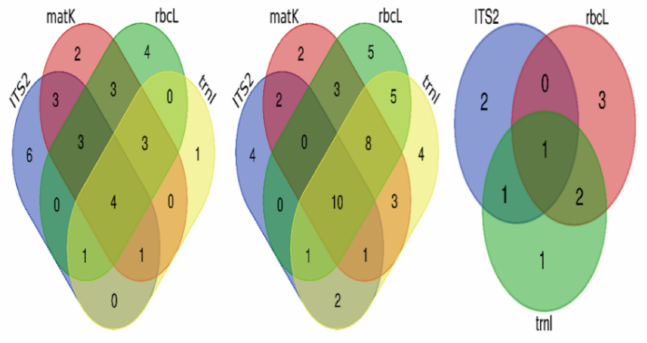
Figure 4. Venn diagrams for correct identification of species at different taxonomic levels. From left to right: at the species level, at the genus level, and at the family